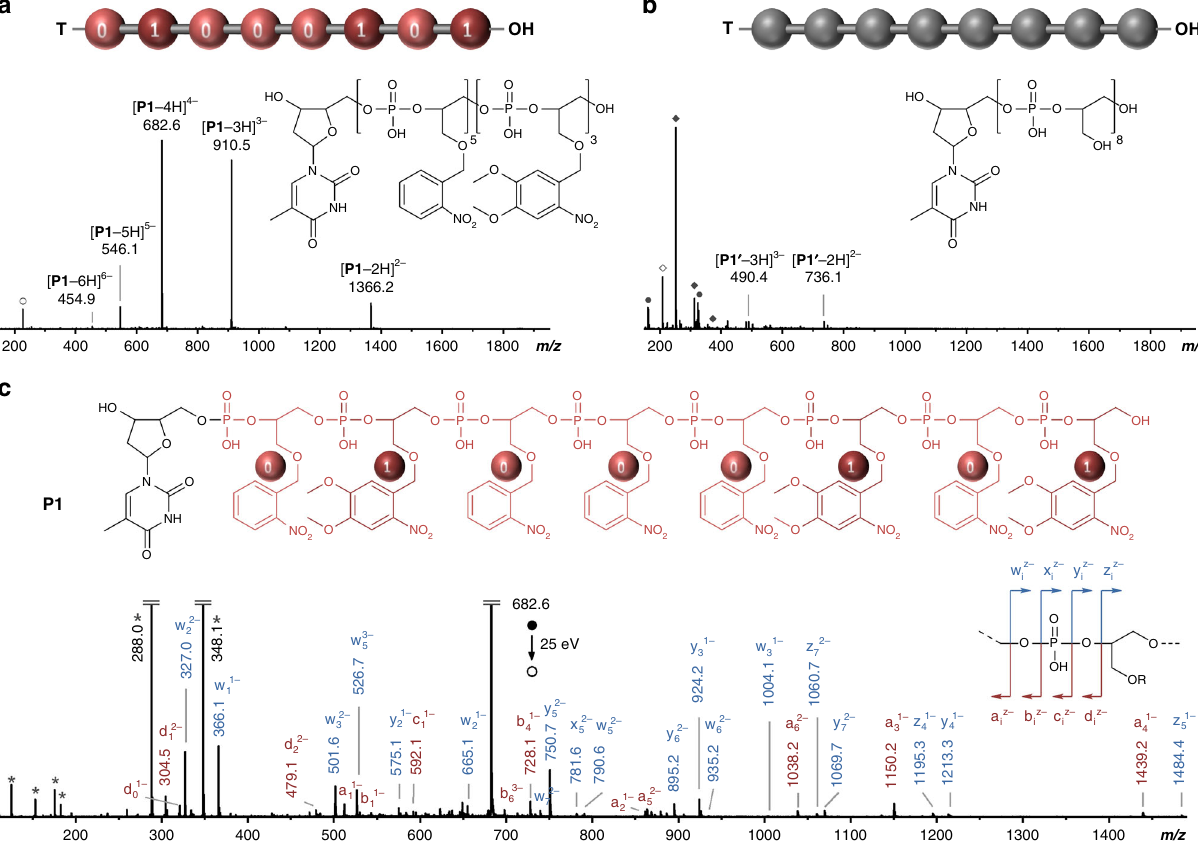
Fig. 2 Example of a photo-erasable digital polymer. ESI-HRMS spectra obtained in the negative ion mode for polymer P1 before ( a ) and after ( b ) light exposure. Open and full dark gray circles indicate clusters of tri fl uoroacetic acid and trichloroacetic acid, respectively. Open and full dark gray diamonds indicate photo-deprotection by-products. See Supplementary Figs. 6, 7 and 15 for interpretation. c MS/MS sequencing of the coded polymer P1 before photo-erasing. This spectrum was obtained by collision-induced dissociation of the [ P1 -4H] 4- precursor ion. The inset schematizes the fragmentation pattern of a phosphate repeat unit. Dark gray stars indicate secondary fragments including deprotonated repeat units at m/z 288.0 and m/z